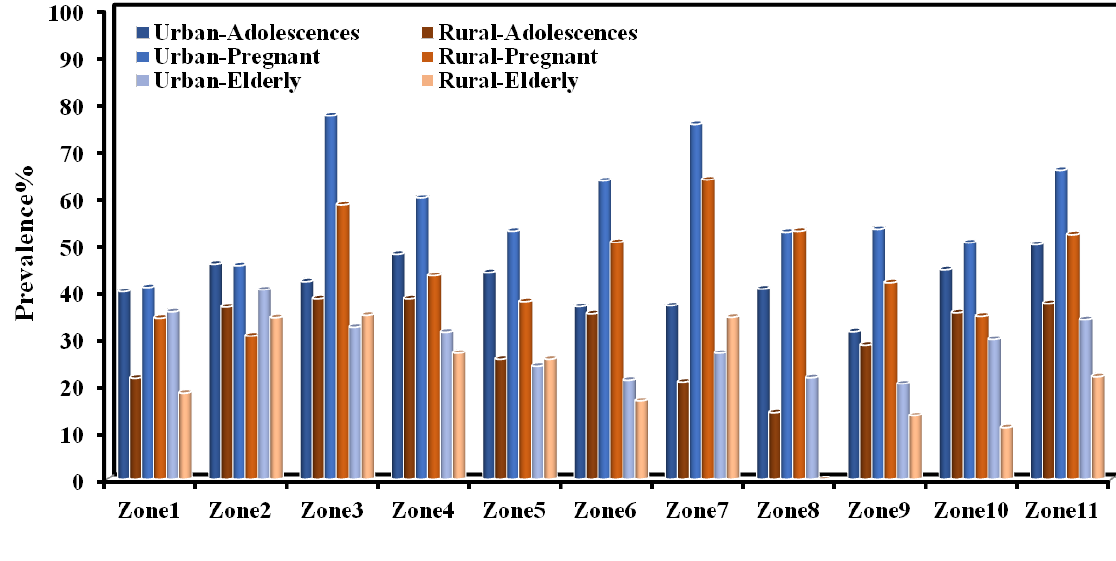
Figure 2 supplementary . The status of vitamin D deficiency in urban and rural Iranian adolescents, pregnant women and elderly groups; Study Poura, Spring